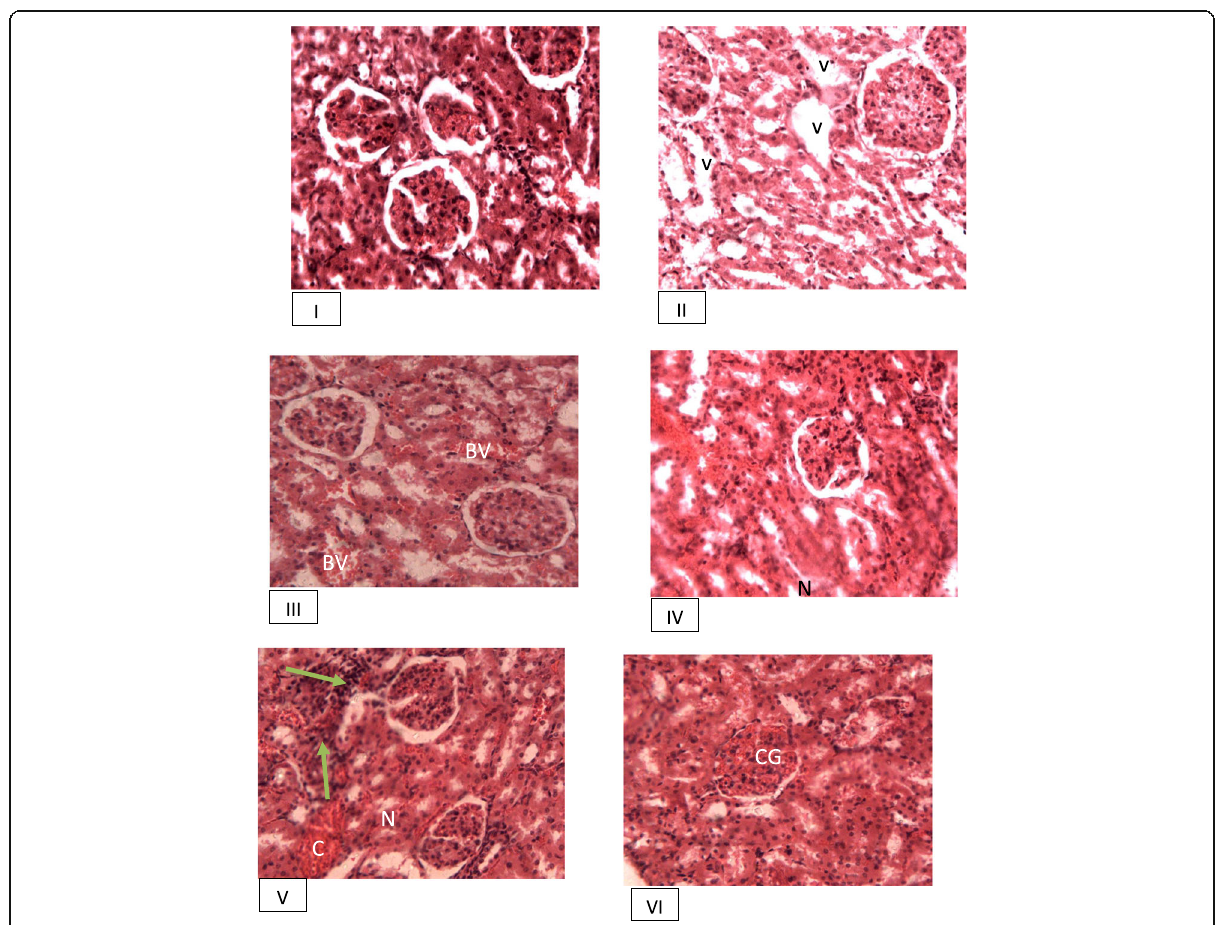
Fig. 2 Kidney histology of the experimental rats. I: rats administered distilled water showing normal kidney histology; II: vacuolar degenerations (V); III: congested blood vessel (BV); IV: necrosis (N); V: congestion (C), necrosis (N) and mononuclear cell infiltration (arrows); VI: congested glomerulus